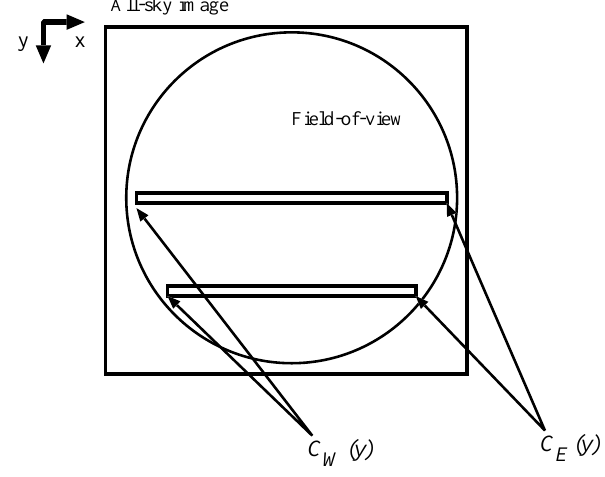
Fig. A1. Extracting brightness distribution: since the field-of-view produces a circular image, only a section of each row (east-west) contributes to the north-south aligned brightness profile. The east- ernmost and westernmost pixels for each row y are C E (y) and C W (y) .